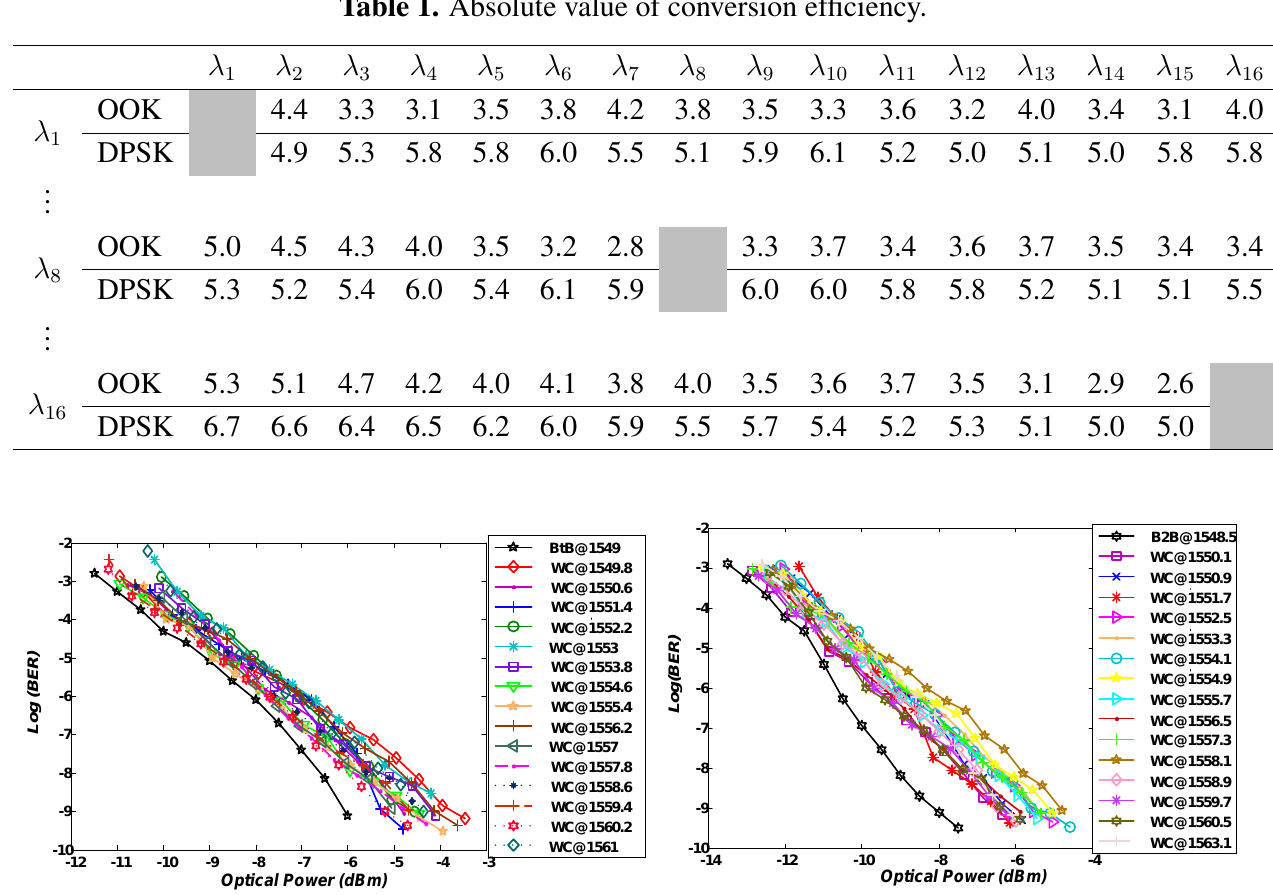
Figure 5. Bit error rate vs. receiver input power for 16 wavelength conversions: ( a ) OOK for conversion range from 0.8 nm to 12 nm, ( b ) DPSK for conversion range from 1.6 nm to 12.8